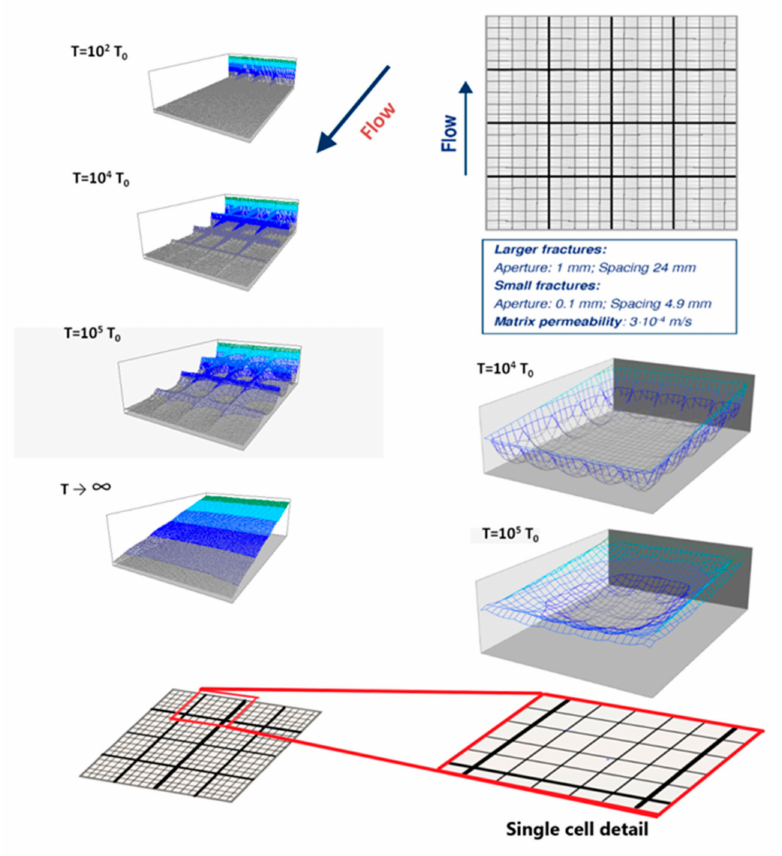
Figure 3. Results of finite difference numerical simulation, involving a simple model of porous body including two hierarchical joint sets under sudden pore pressure increase (in the top right of the figure). Diagram showing the pore pressure trend (on the ordinate axis) for several time steps within the analysed system (T0 denotes the time step value). The diagrams point out how the function p shows, for several time values, some concavities bounded by larger fractures, whilst the detail image of a single cell (bounded by major fractures) allows to recognise, at a smaller scale, similar concavities bounded by smaller fractures (modified after Guerriero et al.